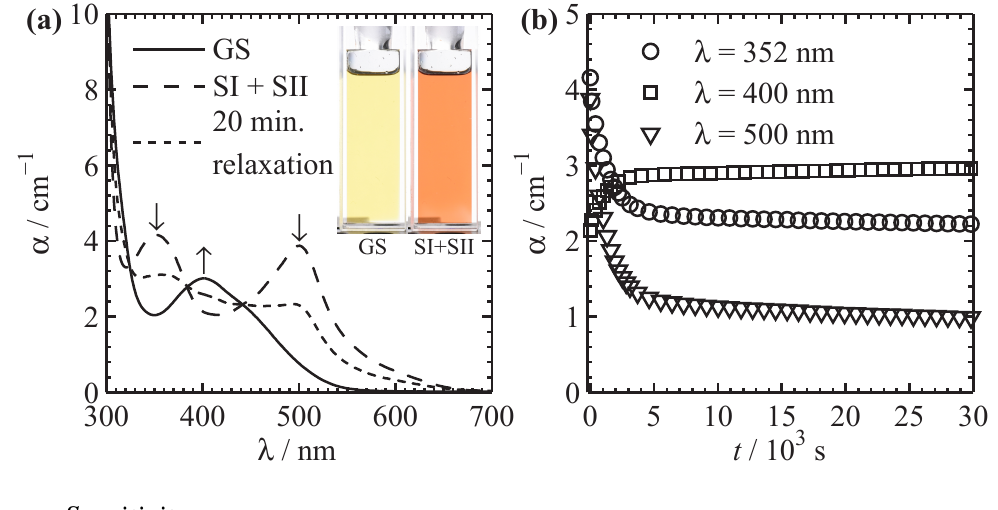
Figure 7. Absorption of 0.20 mM OSO dissolved in PC. ( a ) Absorption spectra for GS (solid line), subsequent to exposure to 405 nm light (SI + SII, dashed), after 20 minutes relaxation at room temperature after exposure (dotted). Inset: Pictures of a 0.88 mM solution; ( b ) Thermal relaxation kinetics of the three dominant VIS absorption bands, t = 0 s equals the spectrum SI + SII in the left frame, t → ∞ equals